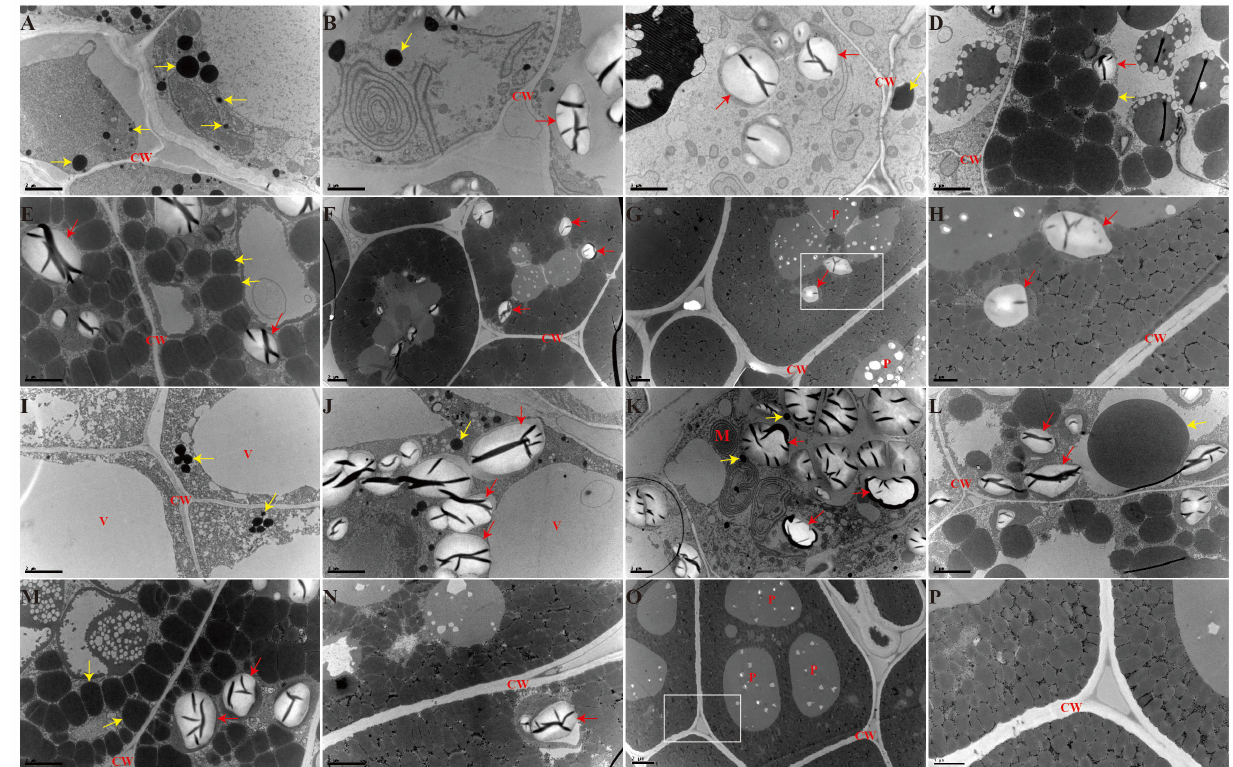
Figure 1. Dynamics of oil bodies in different seed development stages in HOC and LOC materials. ( A – G ) TEM images of seeds taken at 10, 17, 24, 30, 36, 42 and 48 days after fertilization in N53-2, respectively; bar = 2 µ m; ( H ), an enlargement of the area indicated by the white box in ( G ). bar = 1 µ m; ( I – O ), TEM images of seeds taken at 10, 17, 24, 30, 36, 42 and 48 days after fertilization in Ken-C8, respectively; bar = 2 µ m; and ( P ), an enlargement of the area indicated by the white box in ( O ). bar = 1 µ m. H1, H2, H3, H4, H5, H6, and H7 indicated seeds taken at 10, 17, 24, 30, 36, 42 and 48 days after fertilization in N53-2, respectively. L1, L2, L3, L4, L5, L6, and L7 indicated seeds taken at 10, 17, 24, 30, 36, 42 and 48 days after fertilization in Ken-C8, respectively. The red arrows show starch granules, and the yellow arrows show oil bodies. M, mitochondrion; V, vacuole; P, protein body; CW, cell wall. The differences of OB size between N53-2 and Ken-C8 at different developmental stages were also analyzed. At stages 3, 4, 5, and 7, the average OB size was significantly higher ( p < 0.05) in N53-2 than that of Ken-C8 (Figure 3A). However, this was reversed